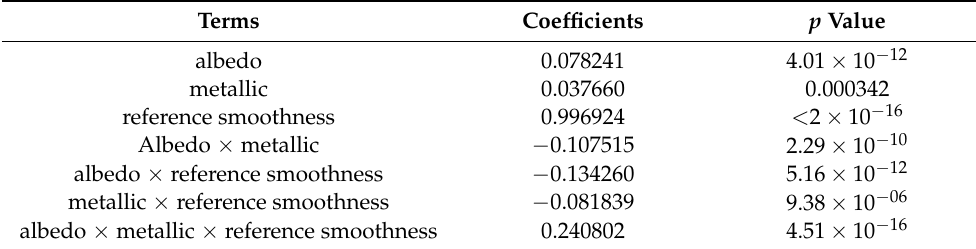
Table 2. The results of multiple linear regression.